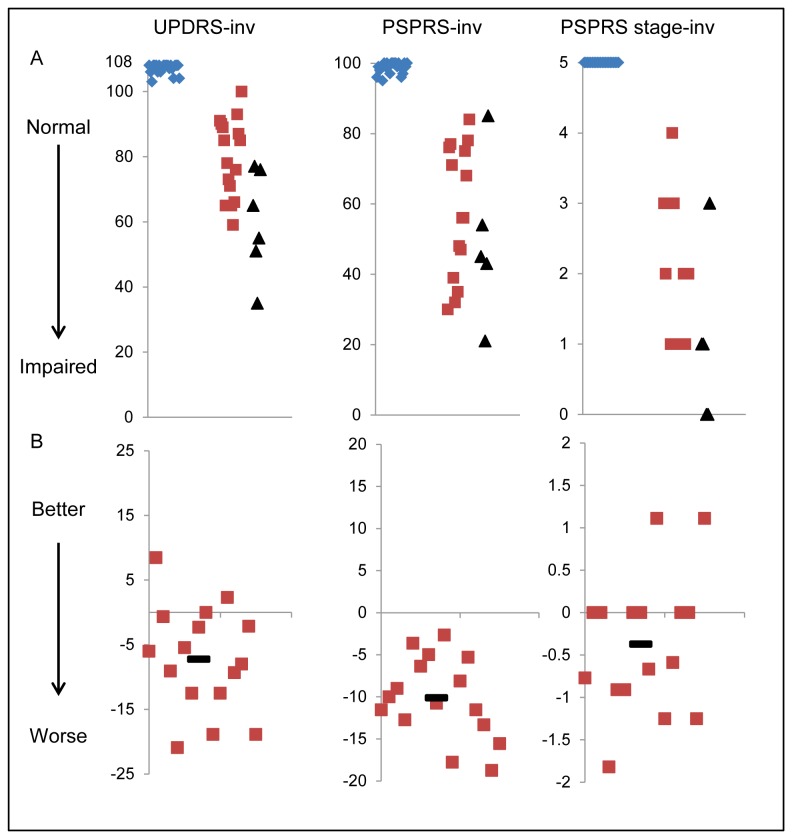
Baseline scores and annualised rates of change for motor tests.Row A shows baseline scores on each test. In order that all graphs show decline as lower values, the scores have been transformed by subtracting the participants’ score from the maximum for the test (see methods). Blue diamonds are controls, red squares are patients with PSP. Black triangles mark the baseline score for patients who could not complete interval testing. Row B shows the difference in score between baseline and interval, in those patients who completed both assessments. The score has been adjusted so that it shows the change in score over twelve months Negative values represent worsening of function. In both sets of graphs, the x axis represents a nominal value. In line A the x axis is arranged so that controls are on the left, patients who completed interval assessments are in the middle and patients who did not complete the interval assessment are on the right. In line B the scores are arranged randomly. Tests are named at the top of each column. UPDRS is the Unified Parkinson’s Disease Rating Scale motor sub scale; PSPRS is the PSP rating scale and PSPRS stage is the stage sub score of the PSPRS. All tests are marked “–inv” to signify that the scale for these tests has been inverted representing deficit from normal.